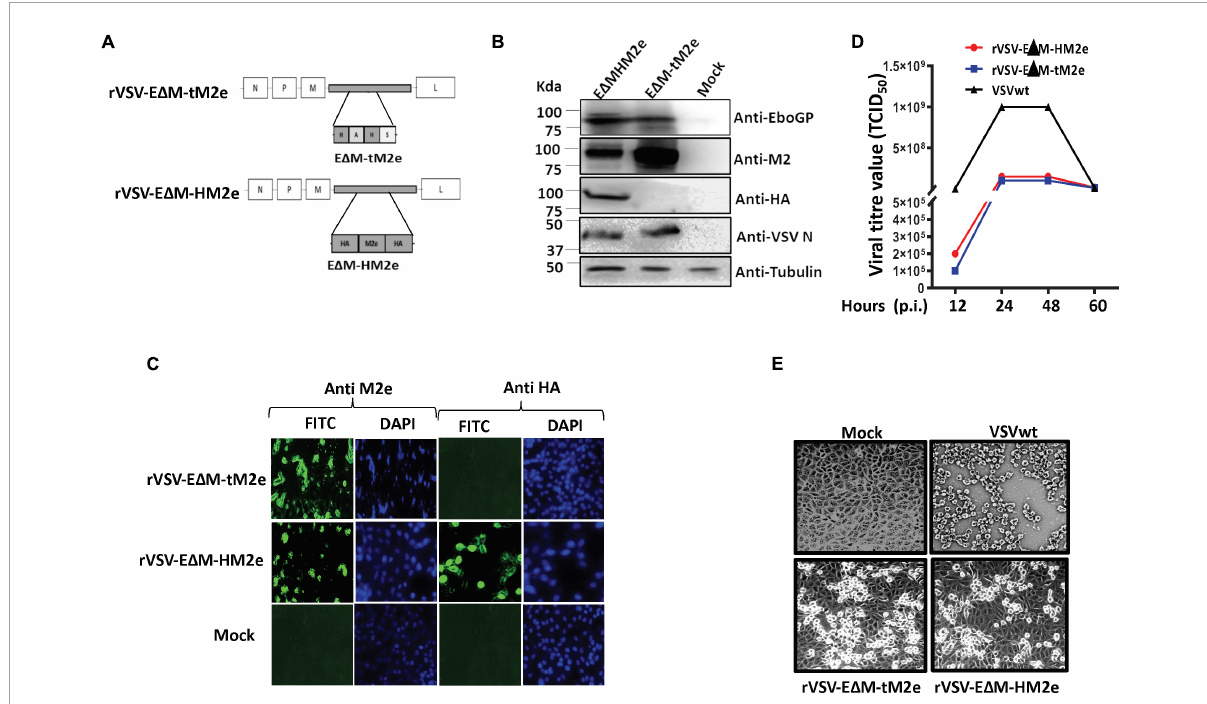
FIGURE3 Generation and characterization of rVSV expressing the E (cid:49) M-tM2e or E (cid:49) M-HM2e. (A) Schematic structures of recombinant vesicular stomatitis virus (rVSV- (cid:49) G) vector expressing the E (cid:49) M -tM2e or E (cid:49) M-HM2e. (B,C) The expressions of the E (cid:49) M-tM2e, E (cid:49) M-HAM2e, EboGP, and VSV-N proteins in the rVSV-infected Vero E6 cells by WB or immunofluorescence assay. (D) Vero E6 cell was infected with rVSV-E (cid:49) M-tM2e, rVSV-E (cid:49) M-HM2e, or VSVwt with MOI 0.01. Supernatants were collected at various time points and were titrated using Reed and Muench method (Gauger and Vincent, 2014). (E) At 48 h post-infection, the cells were observed under the